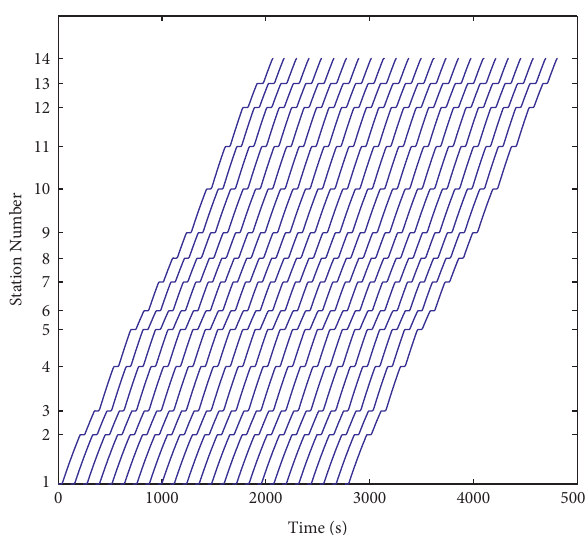
Figure 4: The timetable of Beijing Subway Yizhuang